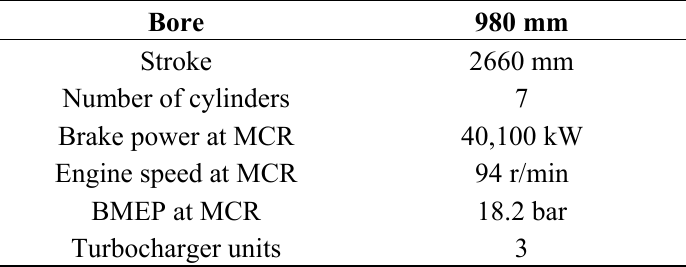
Table 1. MAN B&W 7K98MC engine